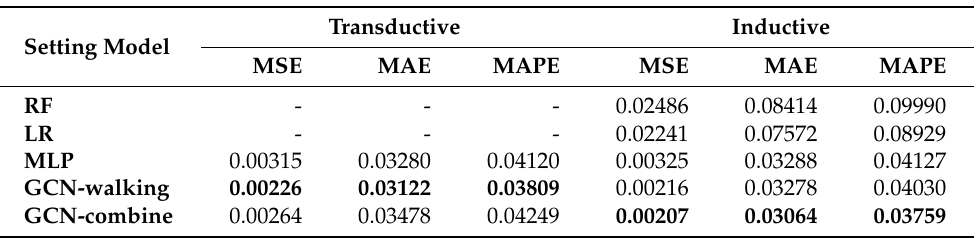
Table 12. Results—Scheme 2 (training/testing/validation set split by region). The best results are shown in bold